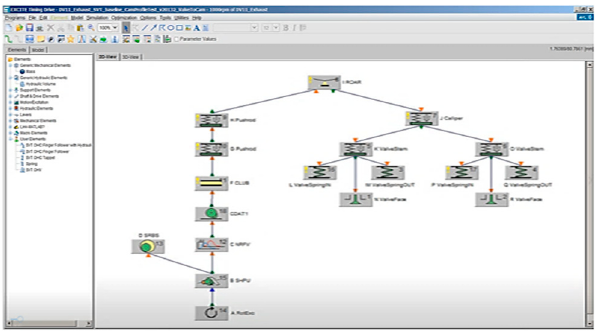
Figure 8. Schematic diagram of AVL EXCITE timing drive dynamics.